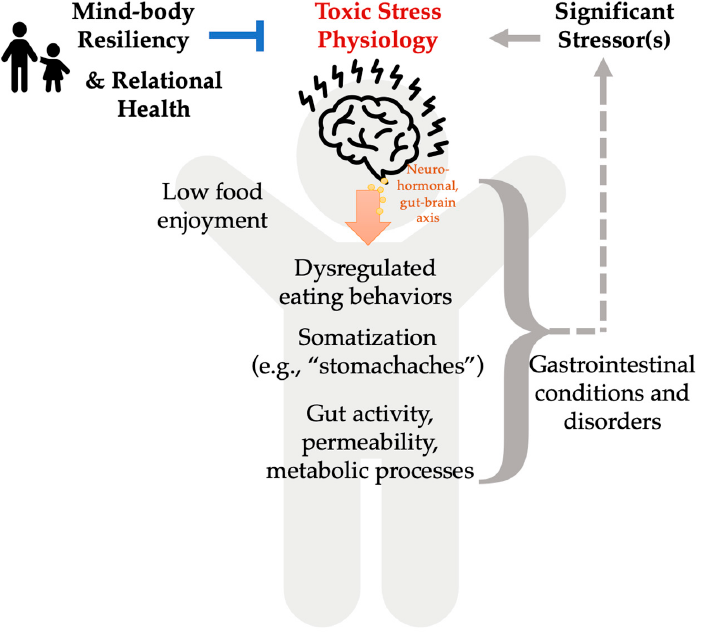
Figure 4. Hypothesized Toxic Stress Manifestations in GI Disease, Resiliency, and Relational Health.